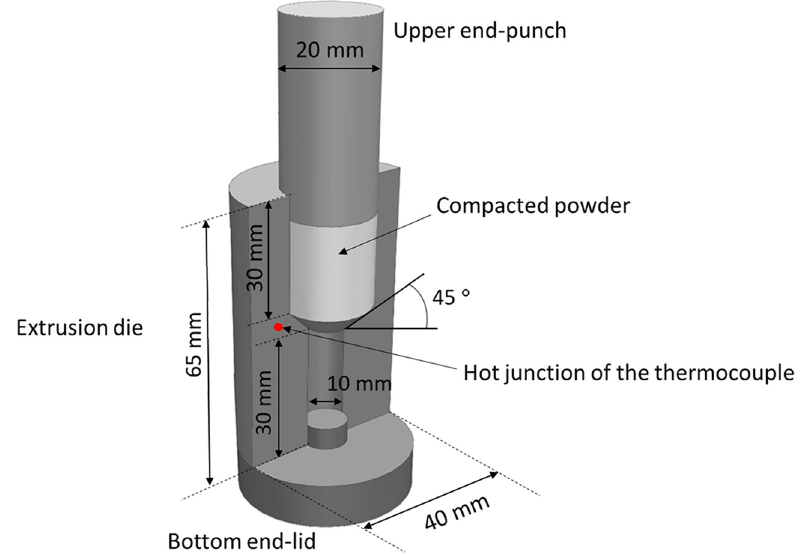
Figure 1: Scheme of the graphite die - set used to conduct the SPE of HA powder.